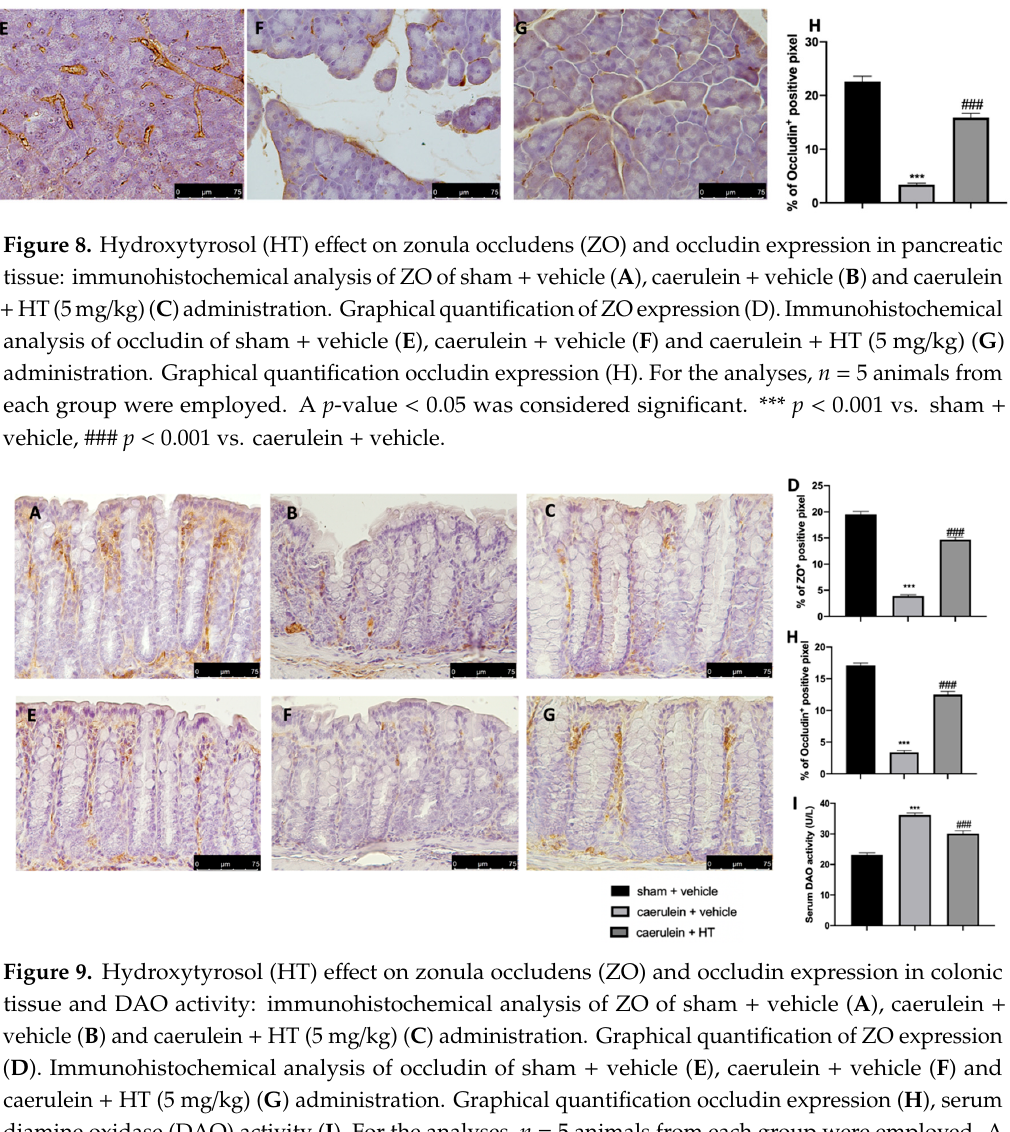
Figure 9. Hydroxytyrosol (HT) effect on zonula occludens (ZO) and occludin expression in colonic tissue and DAO activity: immunohistochemical analysis of ZO of sham + vehicle ( A ), caerulein + vehicle ( B ) and caerulein + HT (5 mg / kg) ( C ) administration. Graphical quantification of ZO expression ( D ). Immunohistochemical analysis of occludin of sham + vehicle ( E ), caerulein + vehicle ( F ) and caerulein + HT (5 mg / kg) ( G ) administration. Graphical quantification occludin expression ( H ), serum diamine oxidase (DAO) activity ( I ). For the analyses, n = 5 animals from each group were employed. A p -value < 0.05 was considered significant. *** p < 0.001 vs. sham + vehicle, ### p < 0.001 vs. caerulein + vehicle.